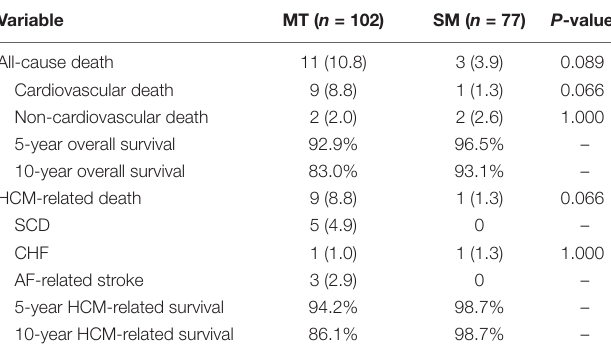
TABLE 2 | The classification of clinical endpoints during follow-up